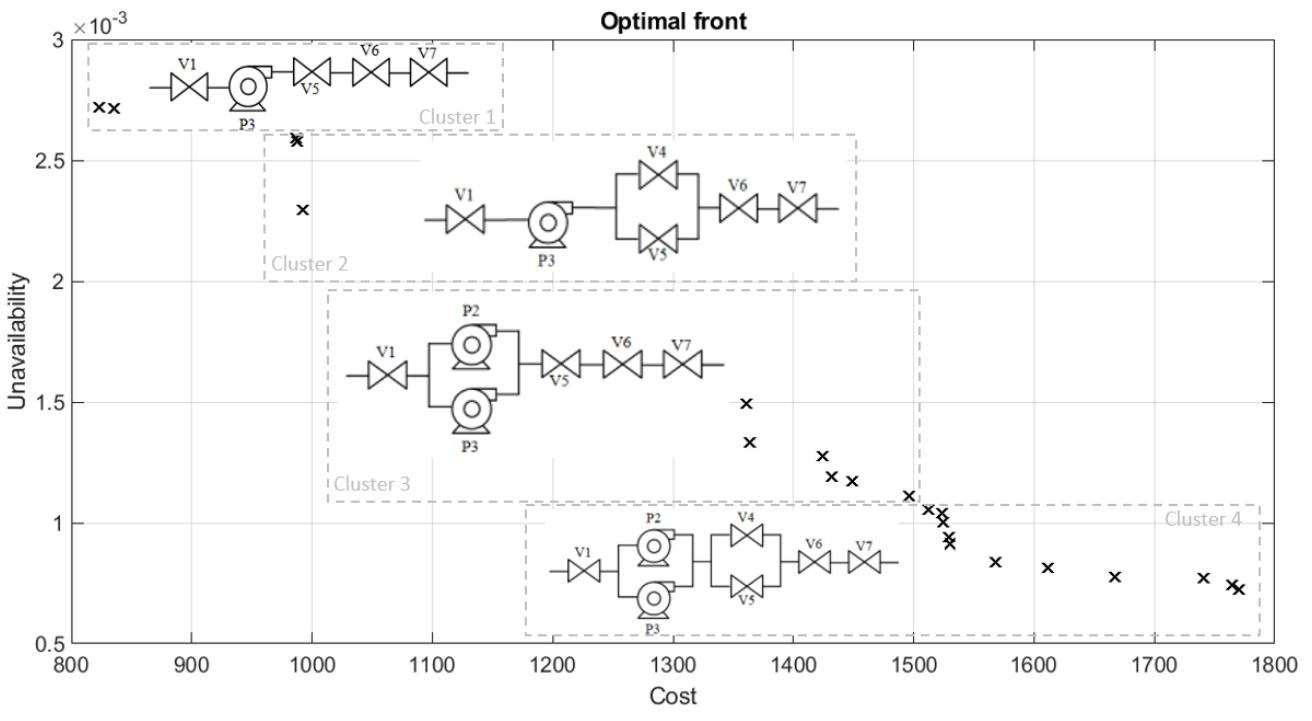
Figure 7. Design alternatives (encoding experiment).